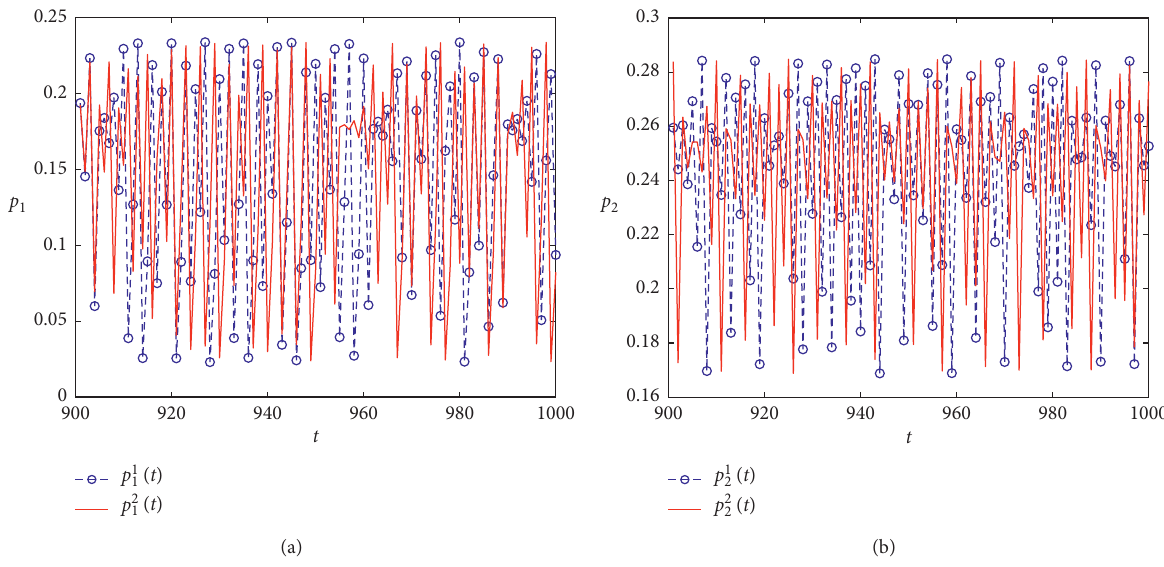
Figure 4: Sensitive dependence on initial conditions for system (12) in the time periods [900, 1000] when k